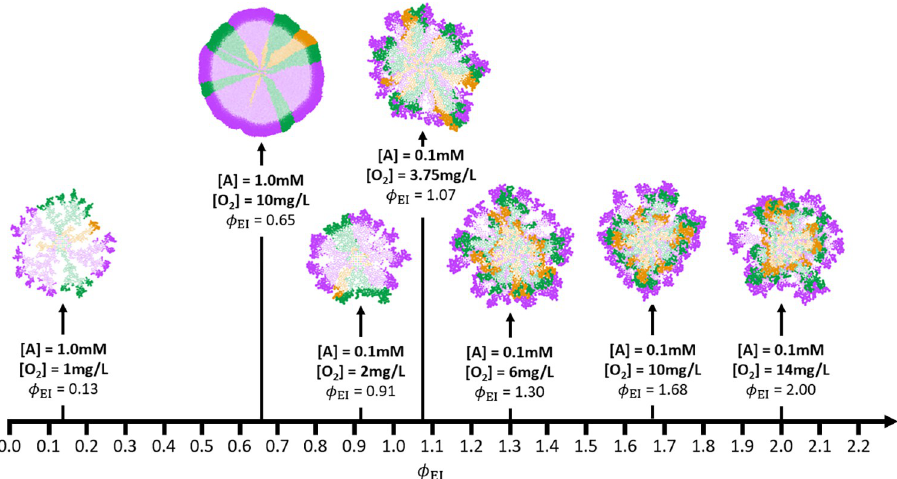
Fig 7. Eco-interaction modulus diagram for simulations considering commensalism and competition for O 2 with [A] = 1.0–0.1 mM and [O 2 ] = 14–1 mg/L. Aggregates captured at steady state (75 d for [S] T = 1.0 mM and [O 2 ] = 1 mg/L; 50 d for all other conditions). Inactive bacteria are shown in a lighter colour. Eco-interaction modulus calculated by Eq 1 for each replicate. Colour legend: B1 –purple; B2 –green; B3